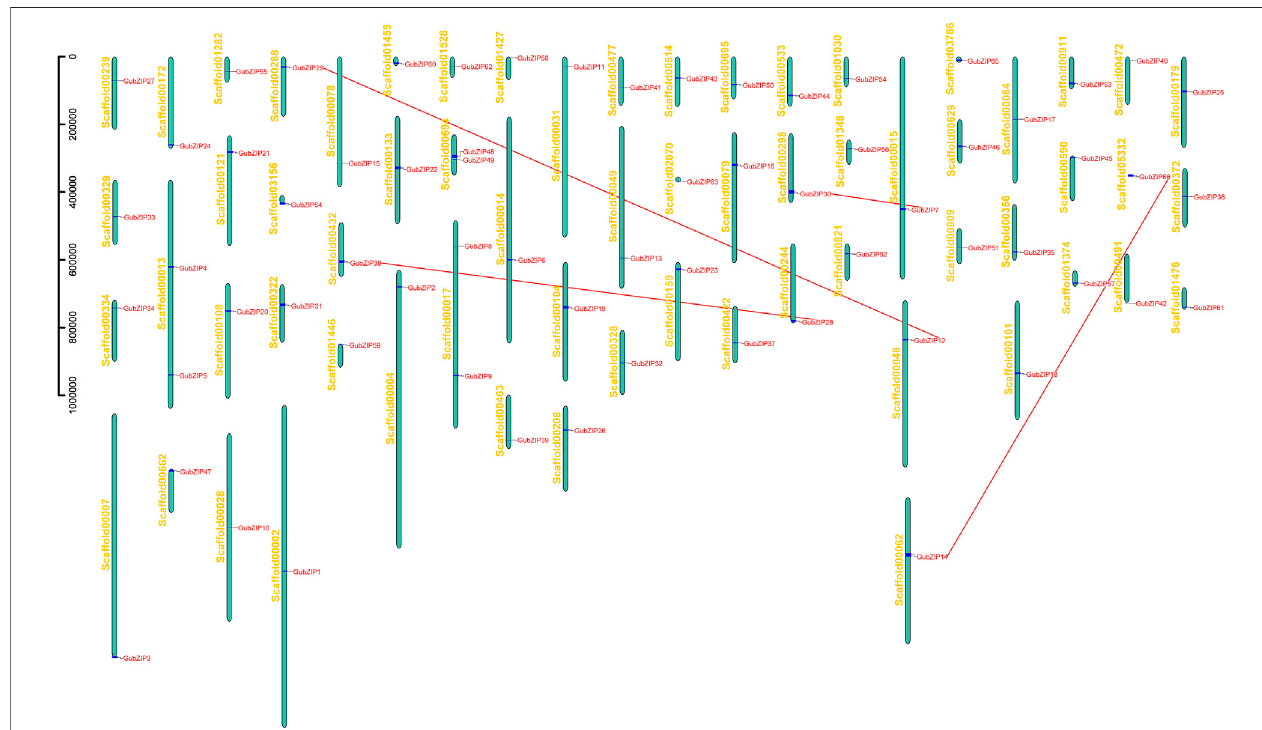
FIGURE3| Chromosomescaffolddistributionof GubZIPs . GubZIP geneswerelocatedon63independentscaffolds.Theverticalcolumnrepresentsscaffold,with the number on the left. Pairs of duplicate genes are represented by red dotted